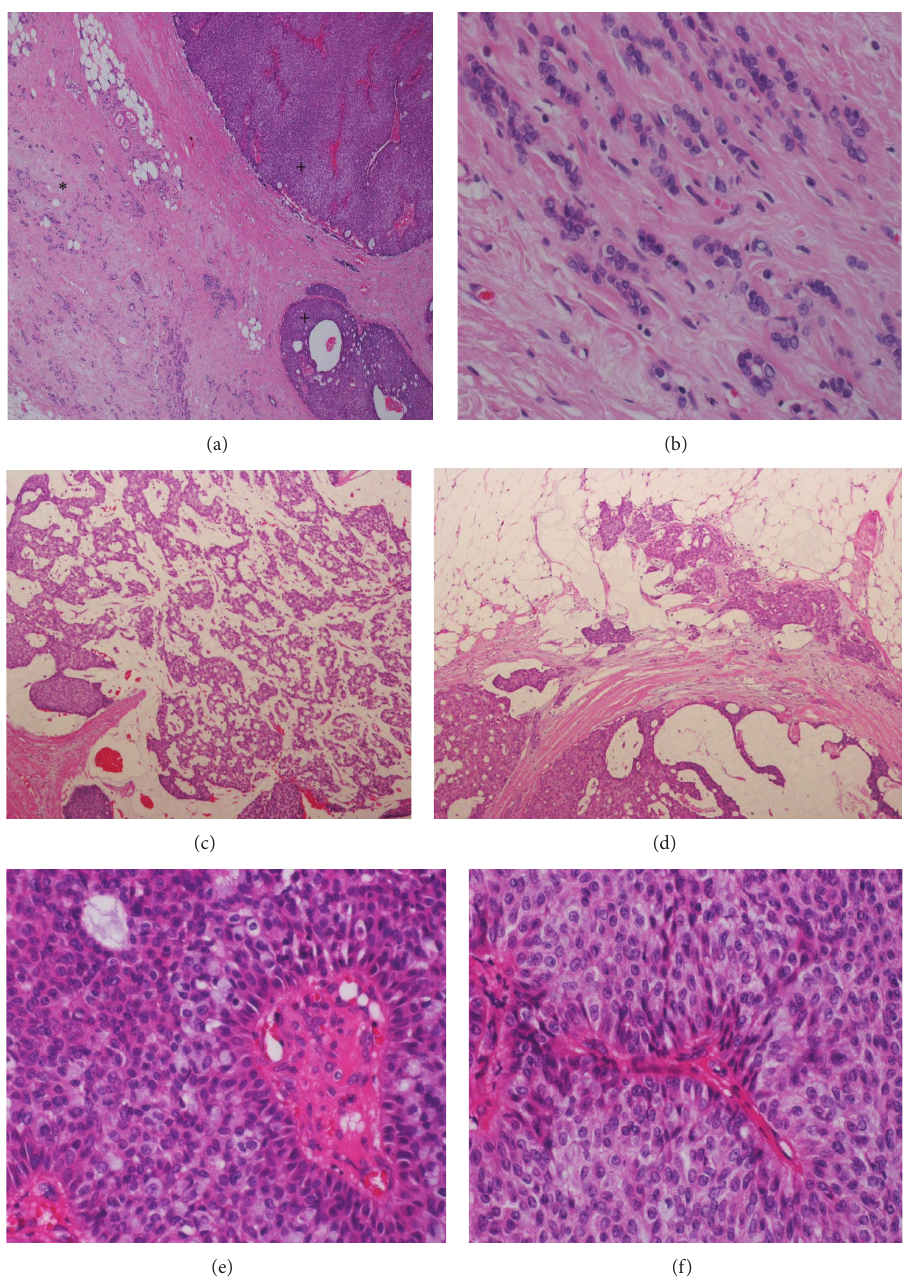
Figure 2: (a) Tumor 1 and the adjacent SPC. The SPC is shown on the upper half (cross), while invasive ductal carcinoma is shown on the lower half (star) (hematoxylin-eosin, original magnification × 10). (b) Tumor 1 was diagnosed as invasive ductal carcinoma NOS. Small alveolar tumor cells structured in a linear growth pattern with fibrosis were observed (hematoxylin-eosin, original magnification × 40). (c) and (d) Tumors 2 and 3 were diagnosed as mucinous carcinomas with tumor cells suspended in abundant cytoplasm mucin (hematoxylin-eosin, original magnification × 10). (e) and (f) SPCs surrounding the bilateral breast. Palisading of tumor cells was evident around the fibrovascular cores. The tumor cells consisted of solid masses of polygonal tumor cells with inconspicuous fibrovascular structures. Extracellular mucin is shown (in the lower portion of 2(e)). The nuclei were small and low grade. Cytoplasmic vacuolization was variably present. Mucicarmine staining demonstrated mucin in the gland lumens and cytoplasm of the tumor cells (hematoxylin-eosin, original magnification ×